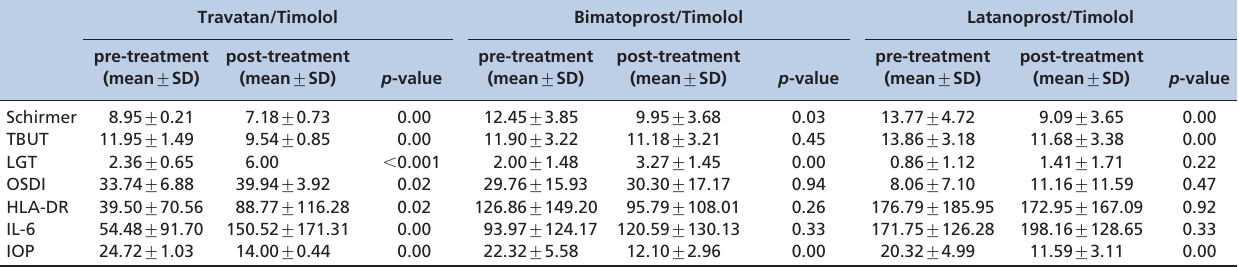
Table 2 - Clinical data prior to and three months after treatment with a fixed combination of travoprost